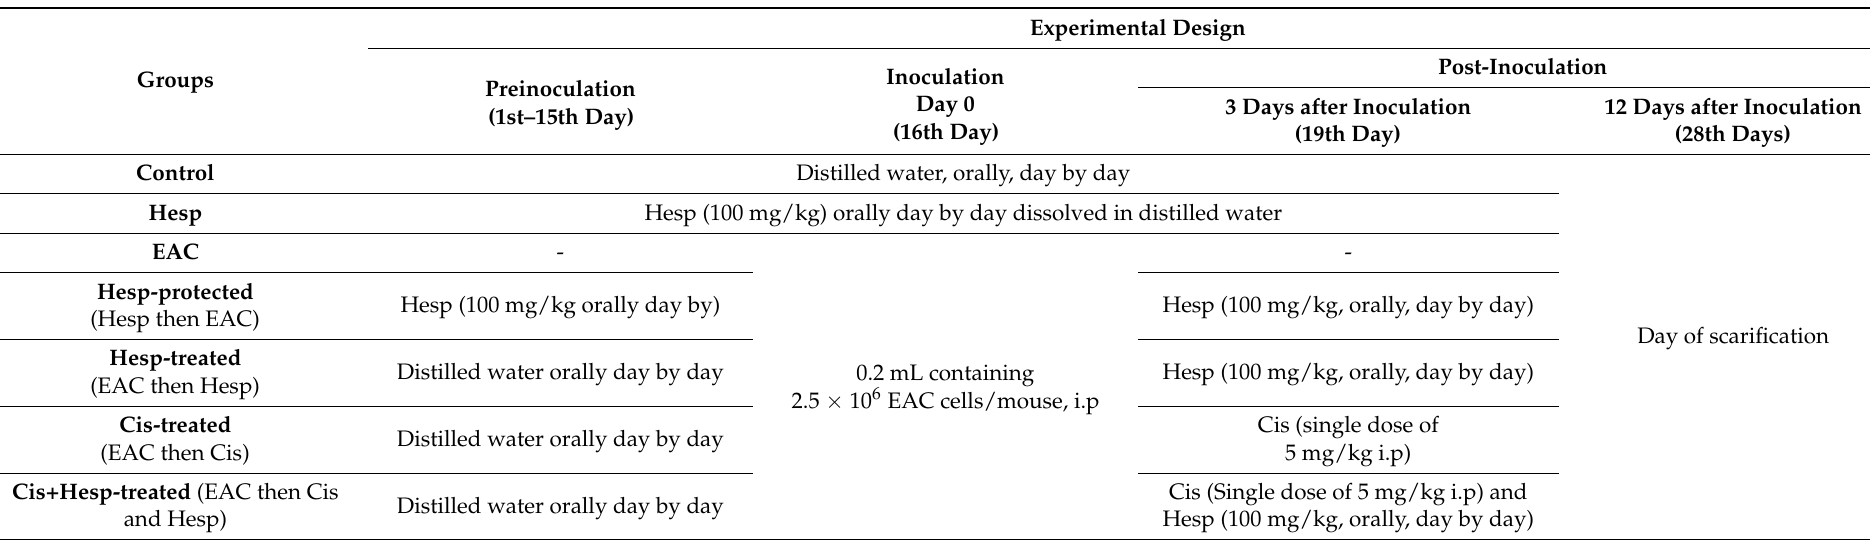
Table 5. The experimental design and animal